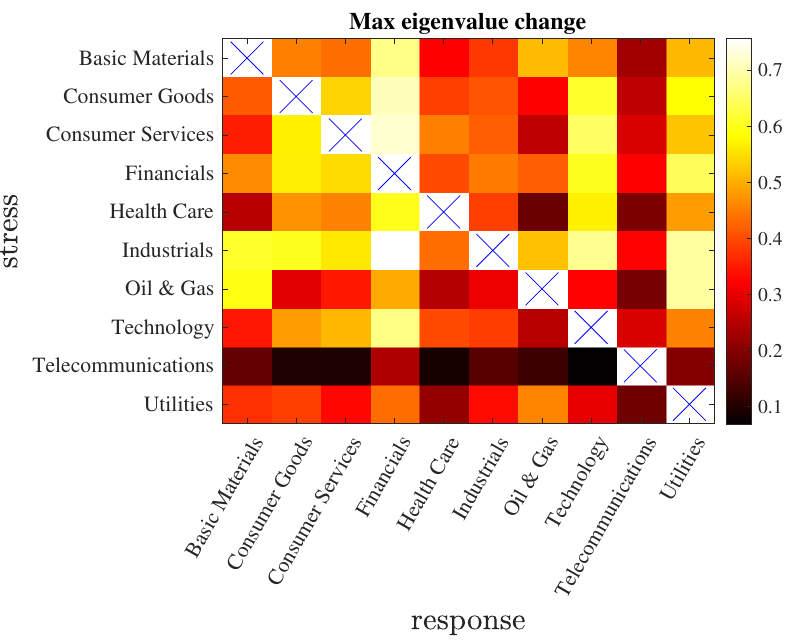
Figure A1. Change in the length of the principal axis, ∆ X → Y .